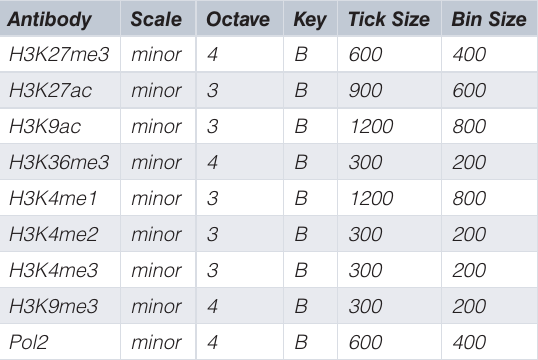
Table 2. Parameters used to convert different ChIP-seq signals into corresponding musical